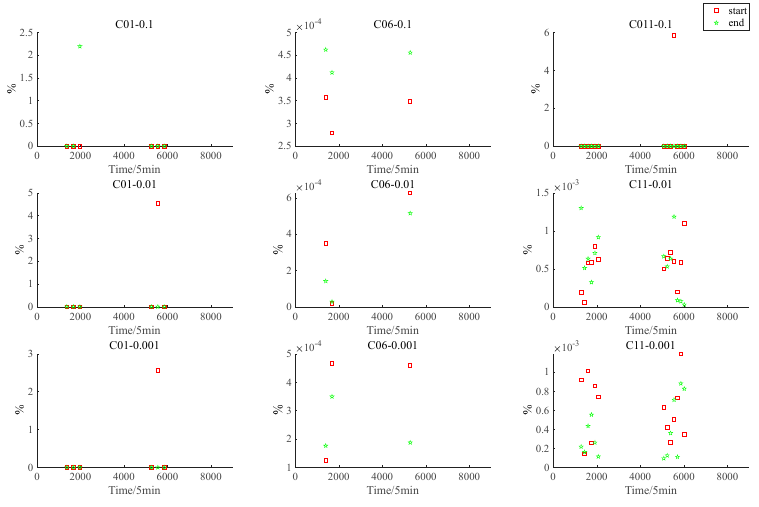
Figure 8. Graphs of Earth occultation start and end times.